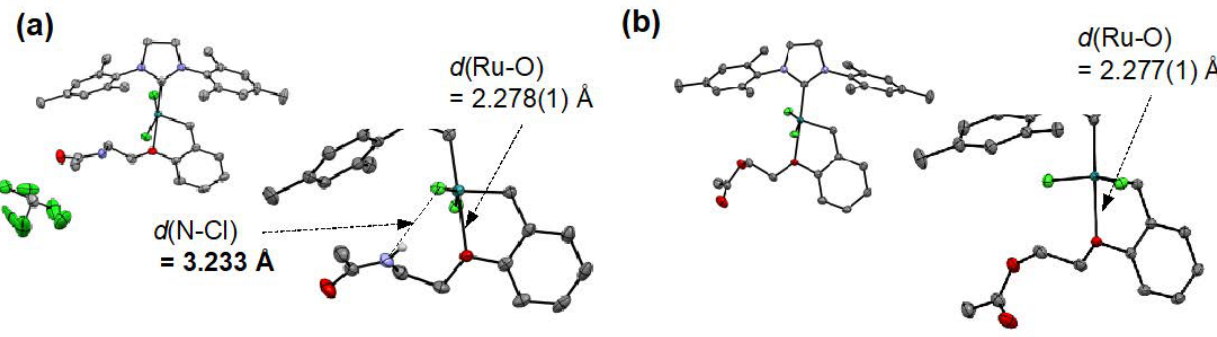
Figure 13. X-ray crystallographic structures of complexes 34 and 38 ; ( a ) structure of complex 34 ; ( b ) structure of complex 38 (reproduced from Ref. [65] with permission from The Royal Society of Chemistry).